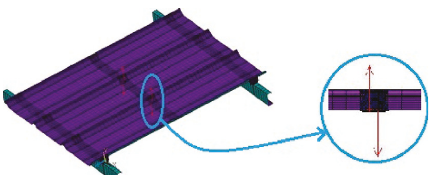
Figure 4: Finite element model for analyzing rotational restraint of standing seam roof